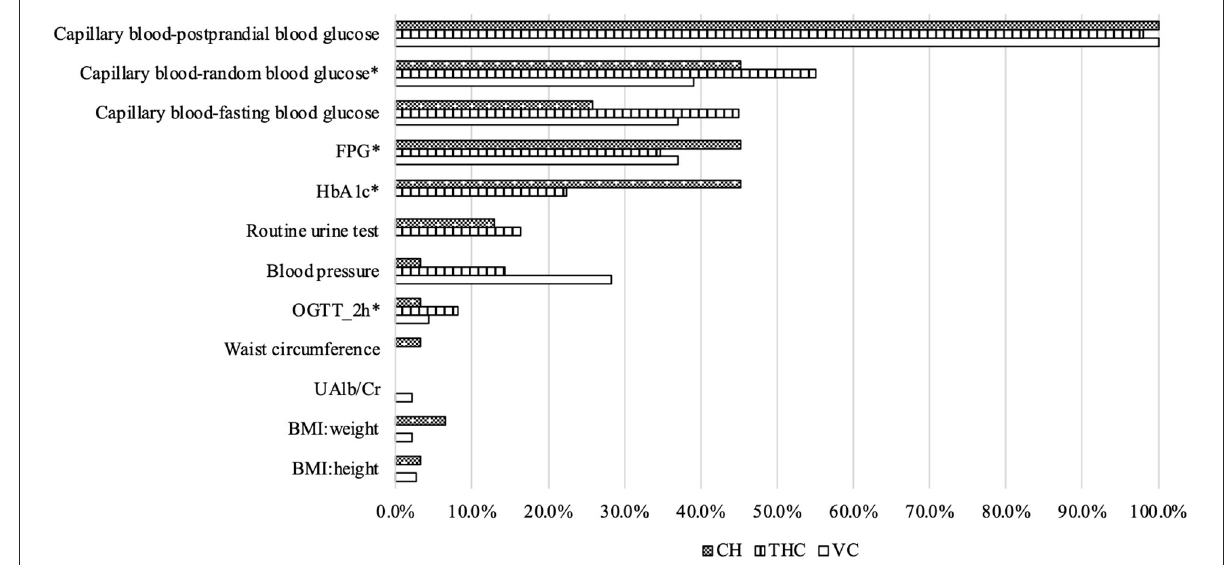
healthcare quality among rural healthcare providers in